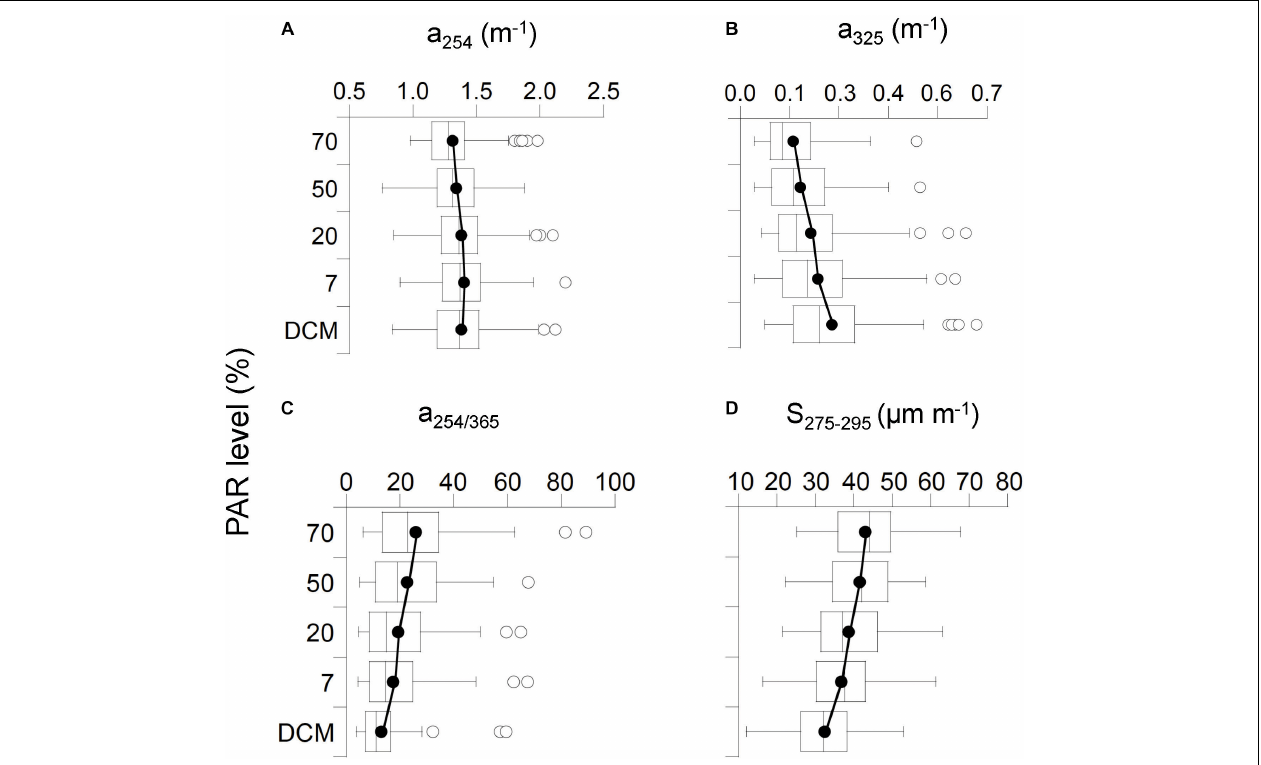
FIGURE 9 | Box and Whisker plots representing average global distribution among the photic layer (five nominal depths) of the optical explained variables: (A) a 254 , (B) a 325 , (C) a 254 / 365 , and (D) S 275 − 295 . Horizontal line represents median; black circles represent means; white-box represent 25–75% percentiles and whiskers extend from the upper (lower) to the highest (lowest) value that is within 1.5x inter-quartile range of the hinge. Solid black line connects global means values within the photic